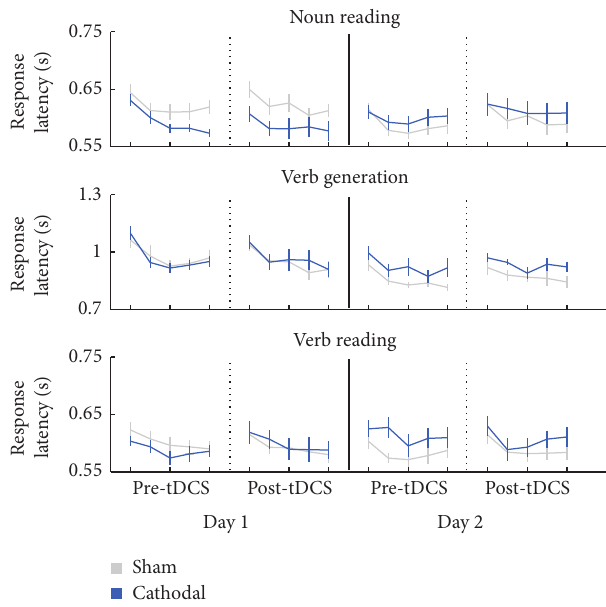
Figure 5: Verbal responses times (s) across blocks 1–5 and for each task,forthetimepointspre-tDCSvisit1,post-tDCSvisit1,pre-tDCS visit 2, and post-tDCS visit 2. Blue represents the group starting with the cathodal condition in the first visit and grey represents the group starting with the sham condition in the first visit. Error bars represent the standard error of the mean